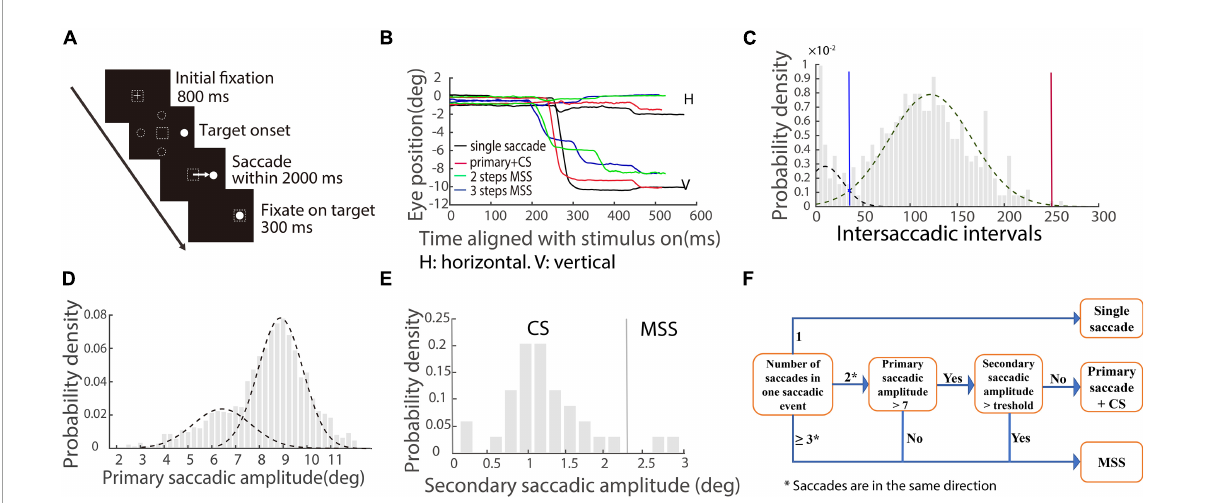
FIGURE1 Schematic illustration of saccadic tasks and methods of quantifying saccades. (A) The paradigm of the visually guided reactive saccade task: White cross and circle represent fixation point and target, respectively. Dashed squares indicate the location of fixation. Dashed circles indicate other potential locations of the target. The white arrow represents the required saccade. (B) Exemplified eye trace of a PD patient. The X -axis represents the time aligned with the saccadic target onset. The Y -axis represents the eye position. Different colors denote different types of saccadic events. (C) The distribution of intersaccadic intervals. Dotted lines represent two unimodal distributions. The blue line is the cross point of the two unimodal fitting curves. The red line is the right zero point of the right unimodal fitting curve. (D) The distribution of primary/largest saccadic amplitudes. Two dotted lines indicate two unimodal distributions. (E) The distribution of secondary saccadic amplitude in which the first responsive saccadic amplitude is ≥ 7 ◦ . The vertical line indicates the mean + 2 × STD of the distribution. (F) Illustration of classifying different types of saccadic